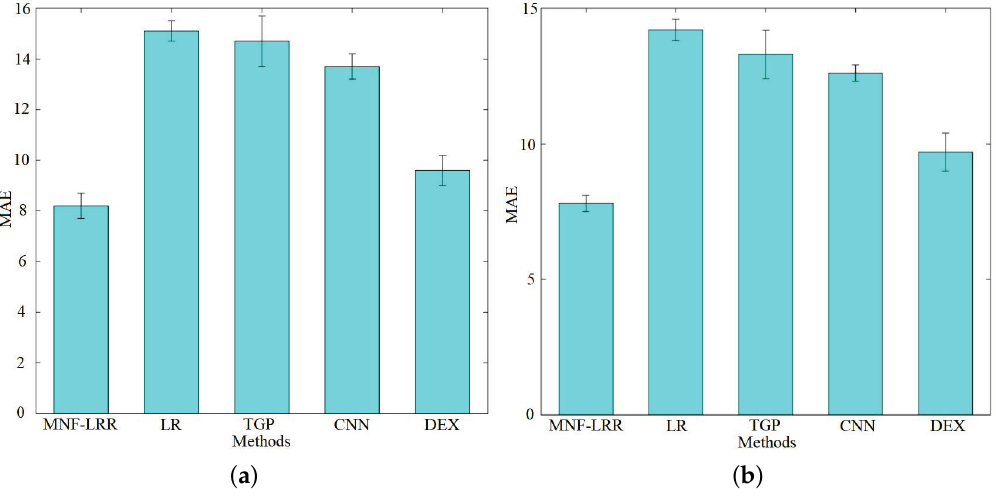
Figure 6. Different methods of age estimation. ( a ) Results of IMDB; ( b ) Results of